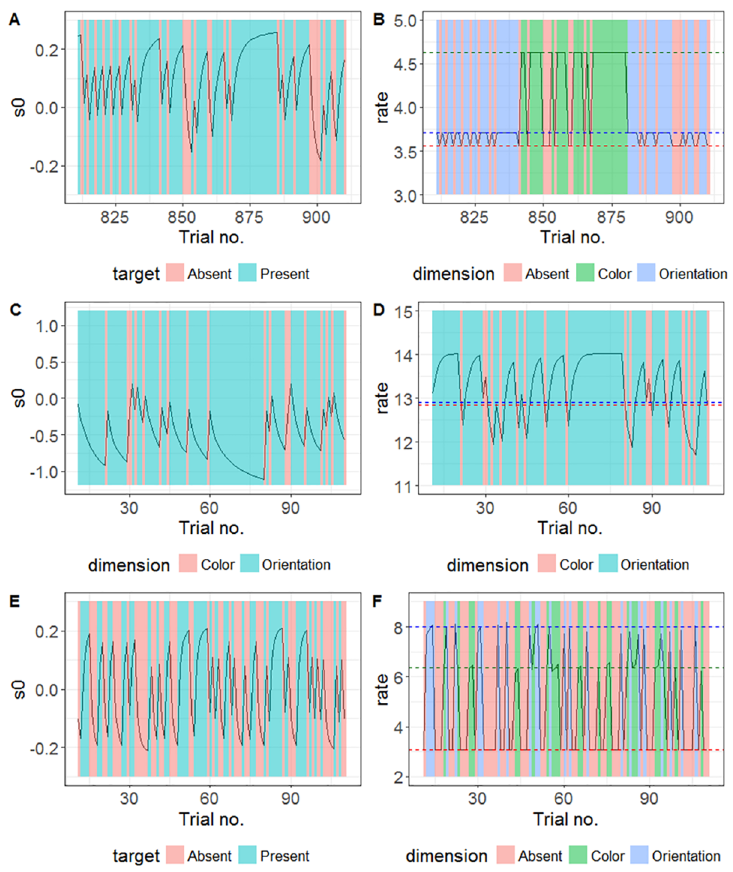
Fig 12. Examples of the updating of the starting point (s0) and the rate. Left panels A, C, and E show examples of starting point updating for a representative sample of trials from typical participants from Experiments 1–3. Panels B, D, and F show updating of the rate for the same trial samples (from the same participants); the dashed lines represent the baseline rates before scaling for target-absent, color target, and orientation target trials (i.e., the rate that would be used on every trial of that type if there was no updating). In each case, updating was based on the best model, in terms of average AIC, for that experiment.